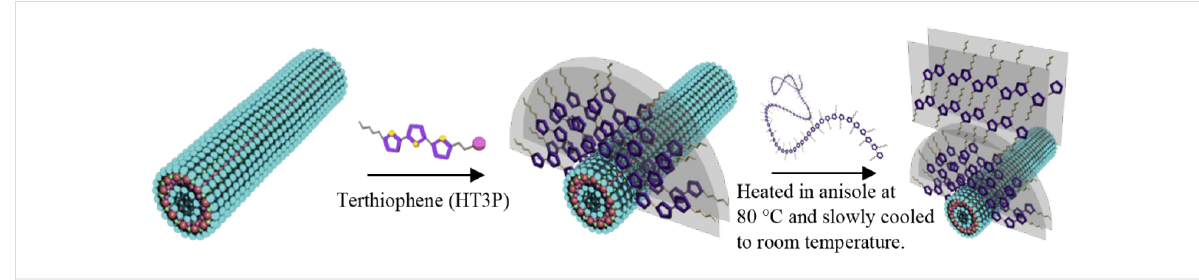
Figure 21: Fabrication and proposed molecular arrangement of P3HT/HT3P-imogolite nanofiber hybrid. Reprinted with permission from W. O. Yah et al., J. Phys.: Conf. Ser. 2011, 272, 012021 [86]. © IOP Publishing